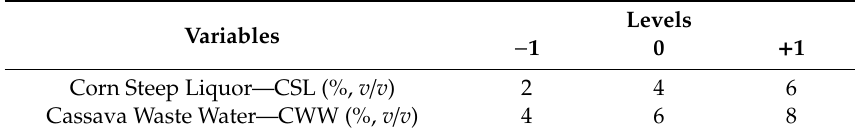
Table 2. Independents variables and levels used in the 2 2 full-factorial design for growth of M. subtilissimus and L. hyalospora.